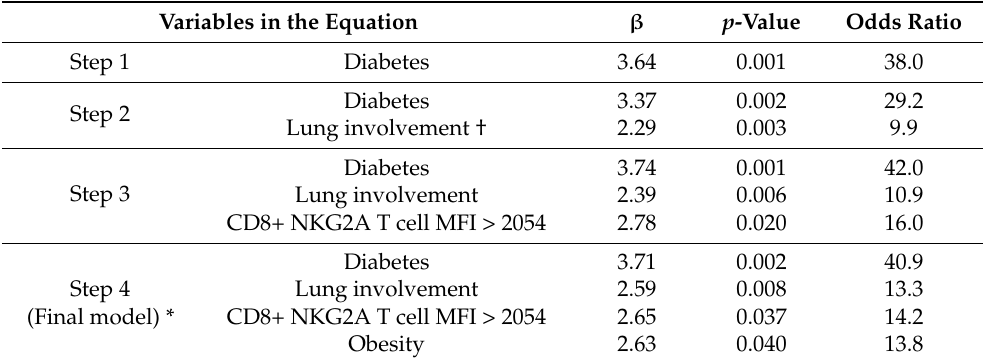
Table 4. Forward stepwise logistic regression model for the prediction of COVID-19 progression to severe